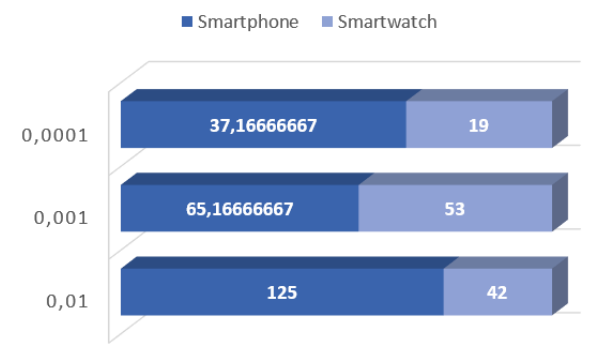
Figure 2. The value of prizes for the work (2 hidden layers) done in the proposed methodology.